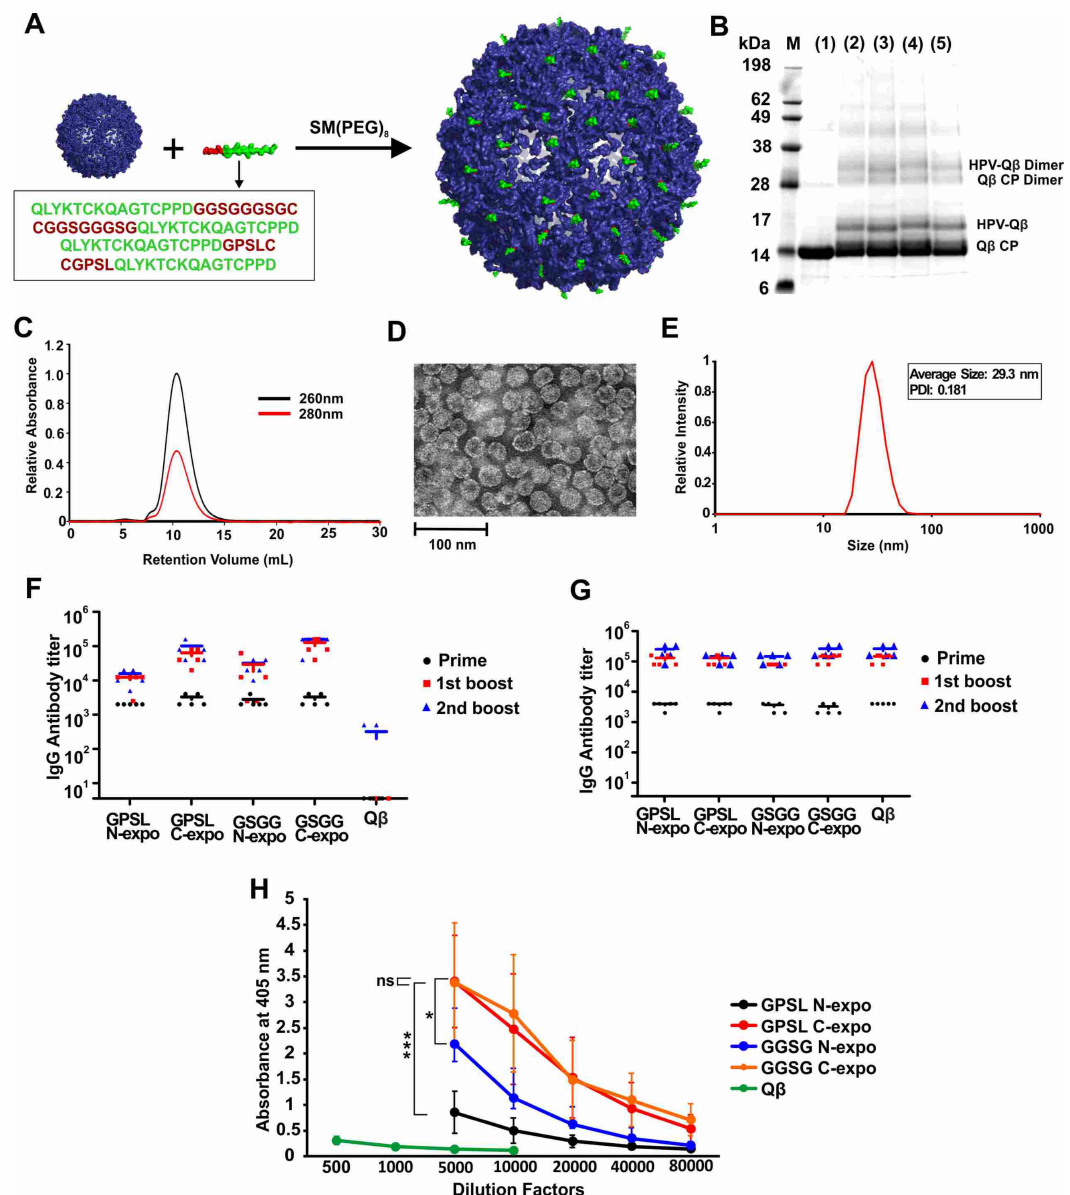
Figure 1. The synthesis, characterization, and immunogenicity of the HPV-Q β conjugates. ( A ) Schematic representation of the synthesis of four HPV-Q β conjugates differing in the linker structure and epitope orientation. ( B ) SDS-PAGE analysis of the Q β and HPV-Q β particles: (1) Q β , (2) GPSL-N-expo-HPV-Q β , (3) GPSL-C-expo-HPV-Q β , (4) GGSG-N-expo-HPV-Q β , and (5) GGSG-C-expo-HPV-Q β . ( C ) FPLC chromatogram of GGSG-C-expo-HPV-Q β . ( D ) TEM image of GGSG-C-expo- HPV-Q β (scale bar = 100 nm). ( E ) DLS analysis of GGSG-C-expo-HPV-Q β . ( F ) Serum IgG titers against the HPV peptide following immunization with the four HPV-Q β conjugates or Q β . ( G ) Serum IgG titers against Q β following immunization with the four HPV-Q β conjugates or Q β . ( H ) ELISA signals at 405 nm for mice vaccinated with different antigens at different dilutions after the second boost. Mice were subcutaneously injected with 30 µ g of each agent on day 0 (prime), 14 (first boost), and 28 (second boost). Blood was collected 7 days after each injection (Data are means ± S.D. for n = 5 mice per group). Asterisks show significance as determined by unpaired two-tailed student’s t -test: ns, not significant p > 0.05; * p < 0.05; *** p <